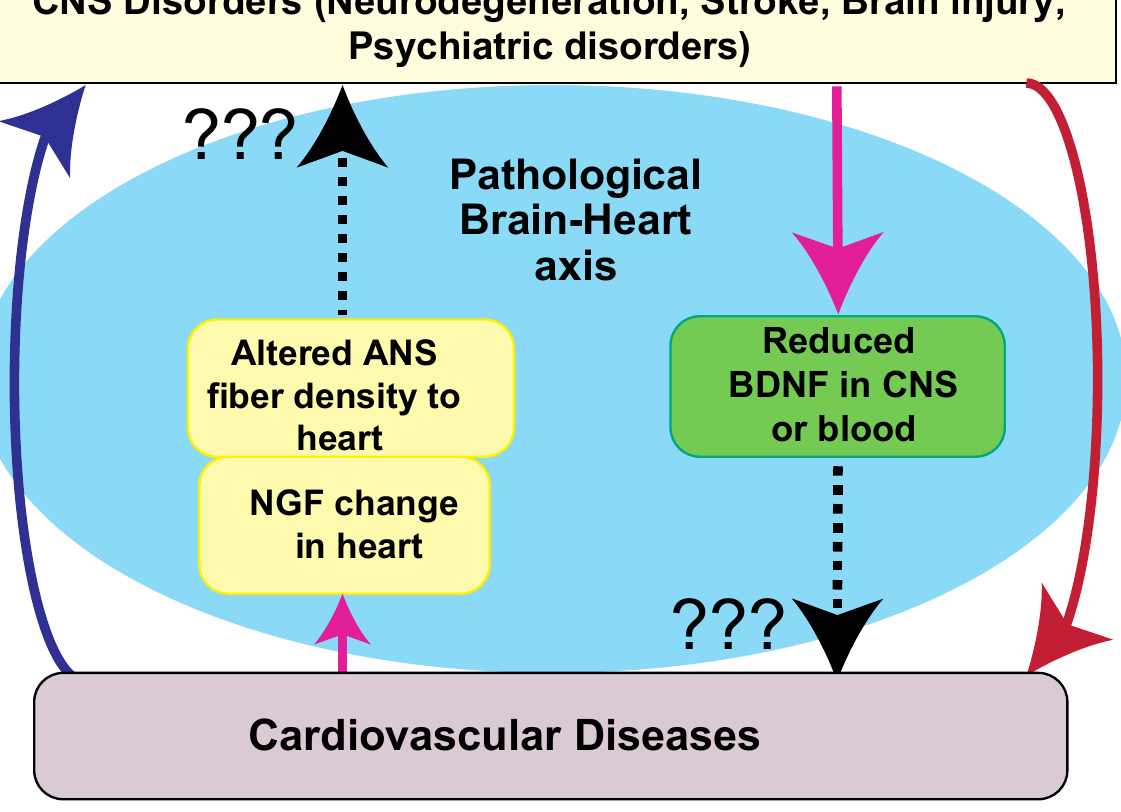
Figure 2. Summary of the potential mechanisms of the brain–heart axis mediated by NTs. As mentioned in Figure 1, cardiac dysfunction-related CNS disorders may be caused by several mechanisms. Epimediologically, CNS disorders are a risk factor of cardiovascular diseases (red downward arrow). Cardiovascular diseases can also be risk factors for CNS disorders (blue upward arrow). Regarding NT involvement, the NGF level and subsequent change in nerve density in the autonomic nervous system (ANS) are altered by cardiovascular diseases (pink upward arrow). Patients with neurological diseases show a reduced BDNF expression in the CNS and serum (pink downward arrow). However, it is still unkown whether these changes may induce both diseases (black dashed arrows + ???).